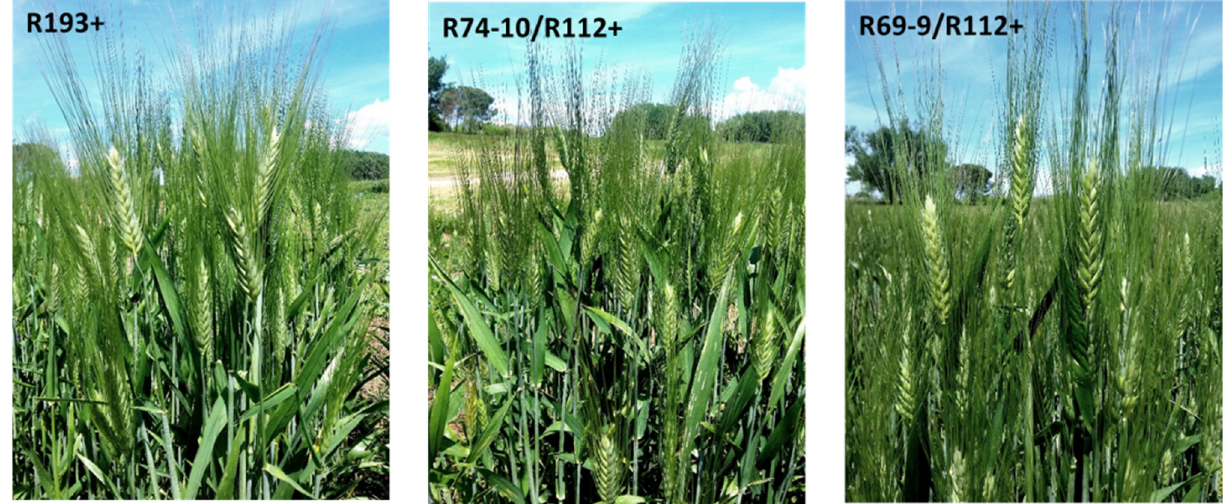
Figure 2. Field view of the R112+ derived nested recombinant lines in 2019 season.